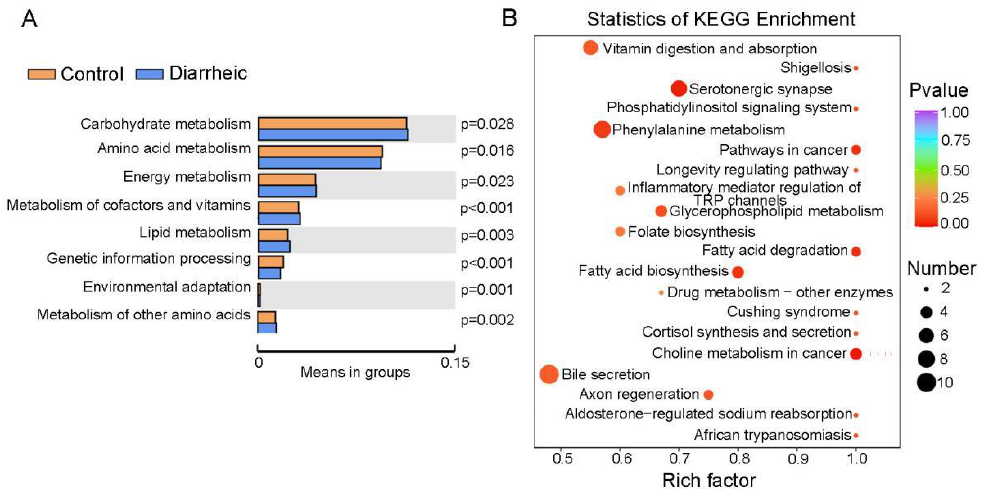
Figure 5. KEGG pathway enrichment analyses of the metabolome and differential metabolites. ( A ) T -tests of fecal microbiome pathway-related gene enrichment. ( B ) KEGG enrichment analysis based on 237 differential metabolites (VIP ≥ 1, p < 0.05) between healthy group and diarrheic group. The color of the point is the p -value; the redder, the more significant the enrichment. Dot size represents the number of enriched differential metabolites.